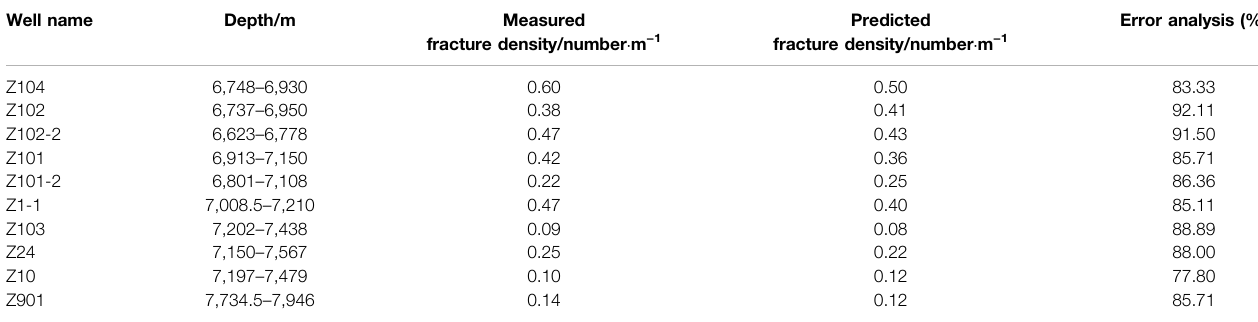
TABLE 2 | Comparison between measured and predicted fracture